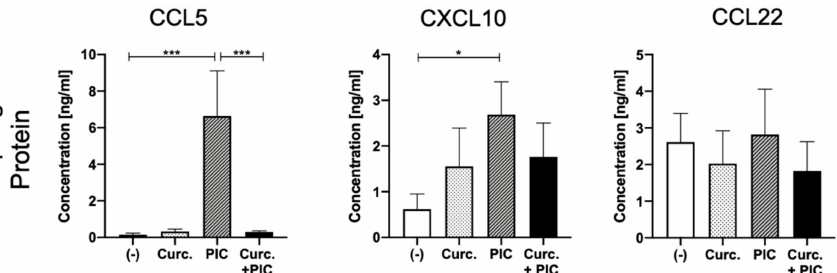
Figure 4. Chemokine expression in macrophage cultures. Detection of chemokines CCL5, CXCL10, and CCL22 from supernatants of macrophage cultures after incubation with the negative control (-), 10 µ g/mL curcumin (Curc.) and/or PIC for 24 h. Results were determined via ELISA. n = 7. Bars represent mean with SEM. P- values were determined with the Mann–Whitney test, with * p < 0.05, *** p <